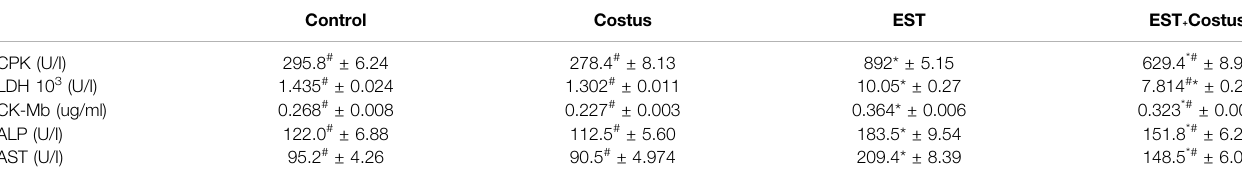
TABLE 1 | Effect of costus treatments on cardiac enzyme levels in the different groups studied.